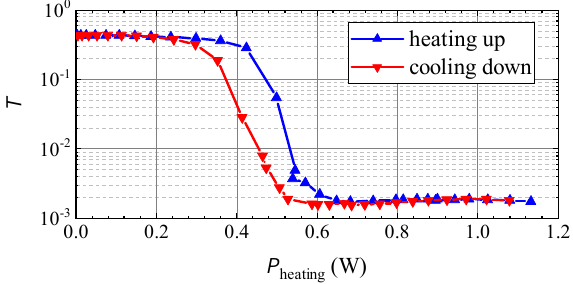
Fig. 4. Transmission change of optical element in relation to heating power inserted in resistive heating film. Each measure- ment was taken after thermal equilibrium was